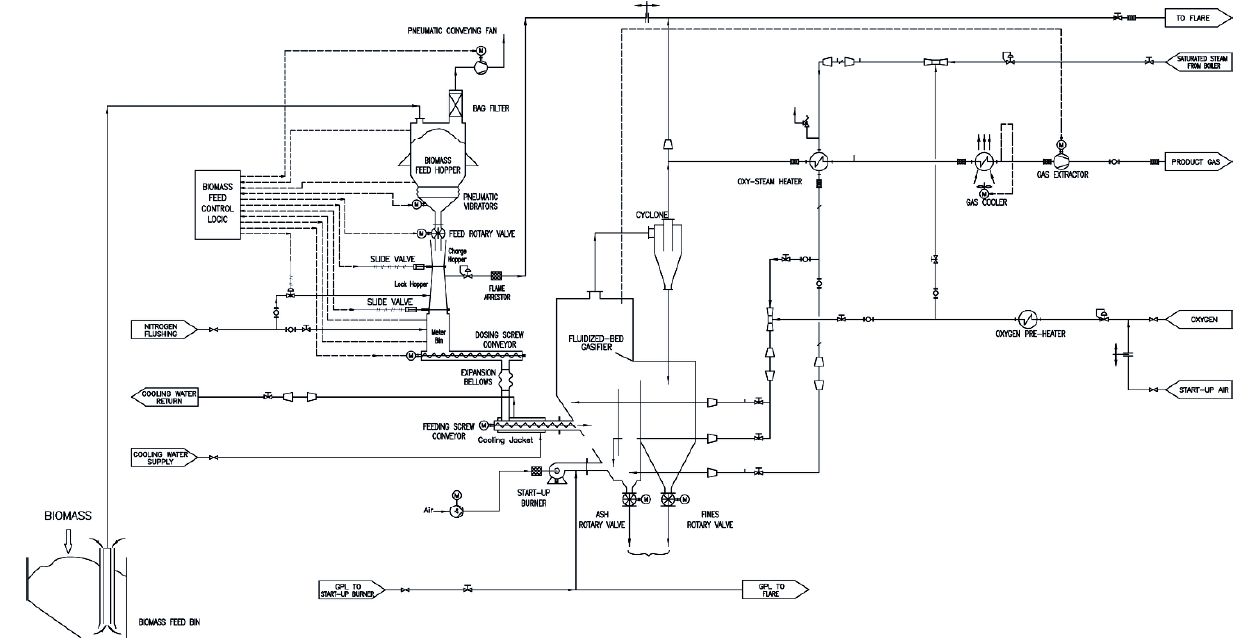
Figure 1. Sketch of the pre-existing 1000 kW th bubbling fluidized bed pilot plant.